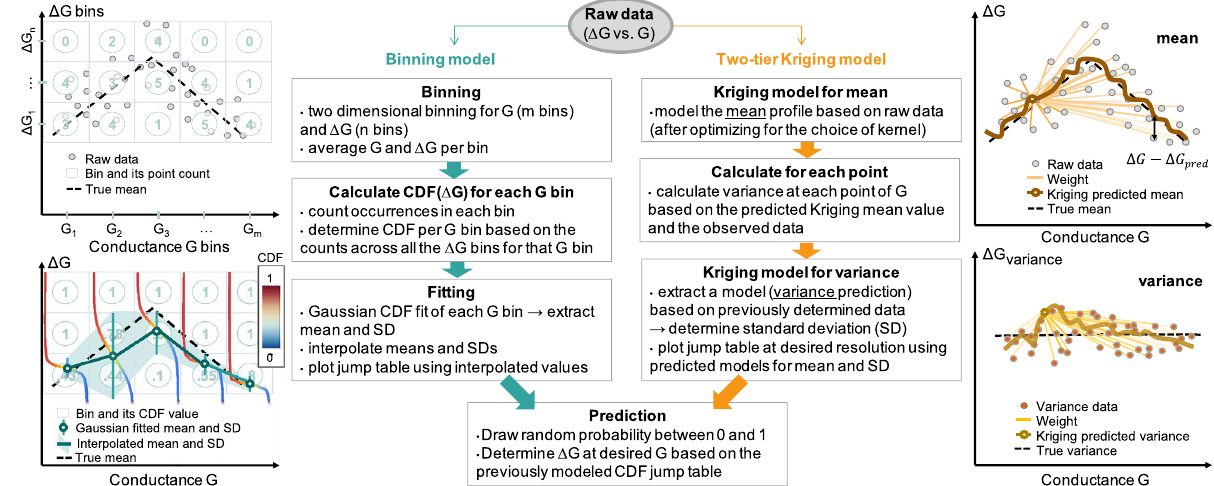
Figure 3. Algorithmic comparison. A binning modeling approach vs. the proposed two-tier Kriging modeling